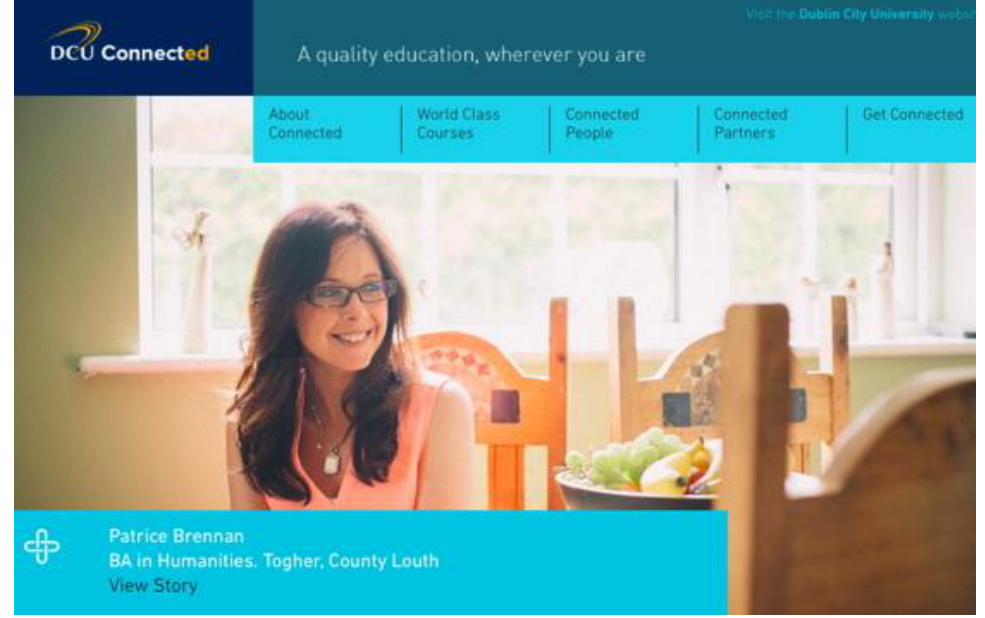
Figure 2. The DCU Connected